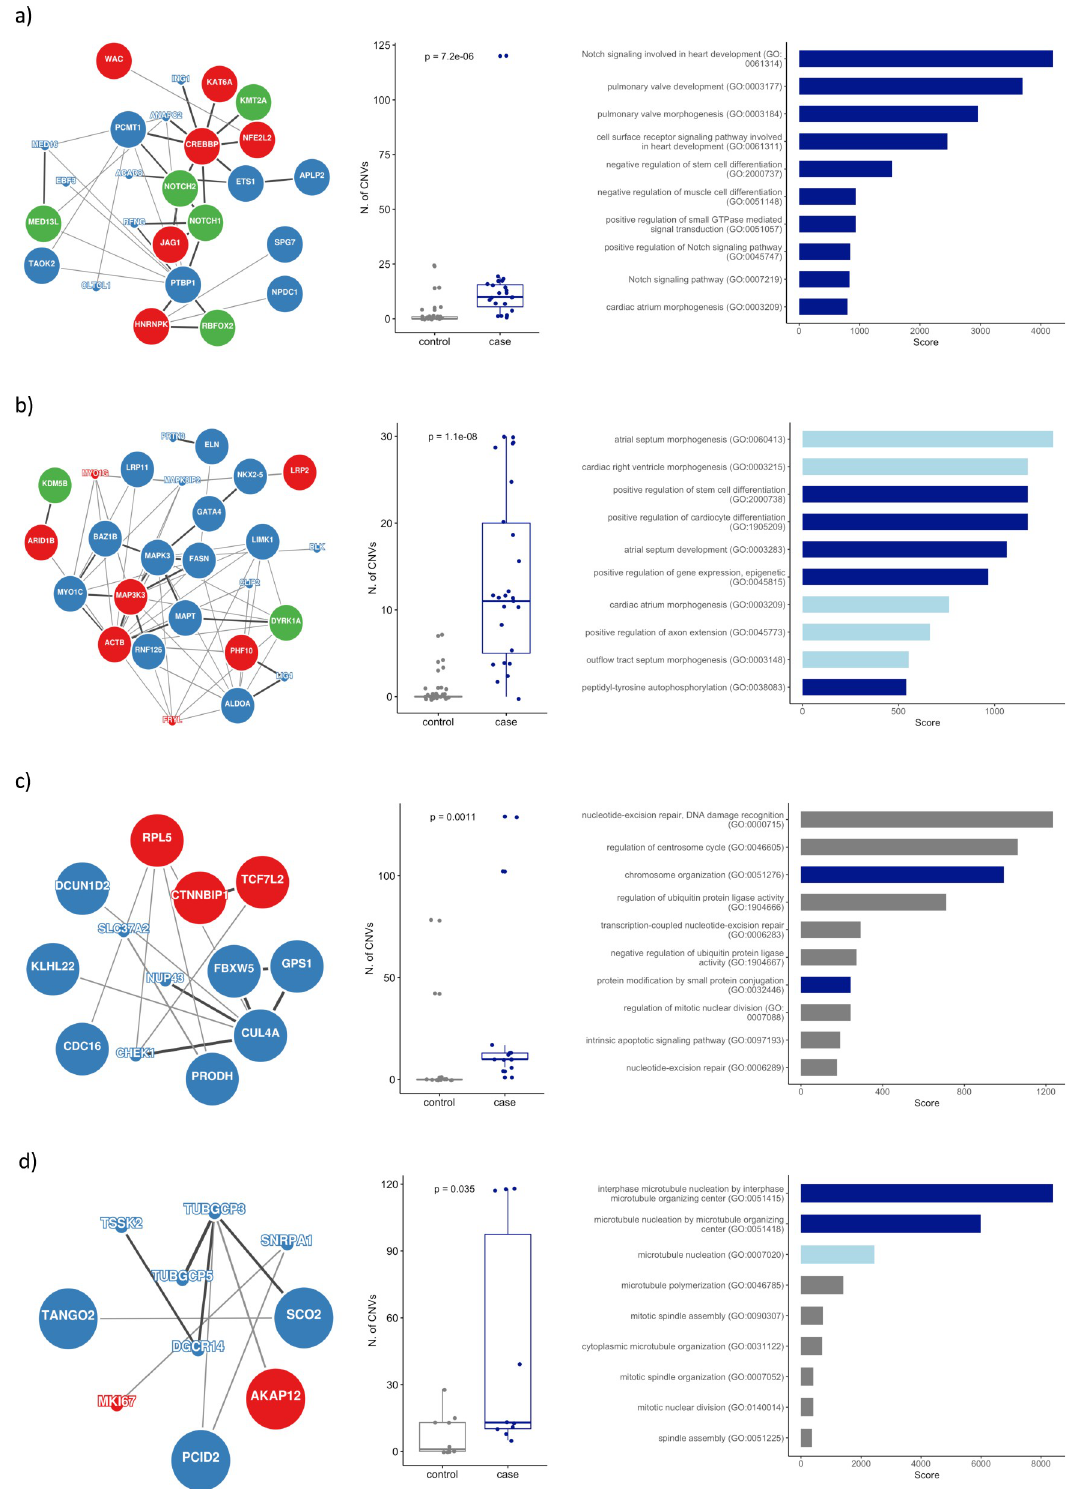
Fig 6. Identification of functional networks enriched for proteins encoded by genes affected by CNVs and/or DNVs associated with CHD. The protein-protein interaction networks (a-d, for clusters 1, 3, 8 and 9 respectively) were identified using GeNets ( S4 Fig ). Proteins are shown as nodes, interactions as edges. Enrichment for CNVs (blue) and DNVs (green) are highlighted.